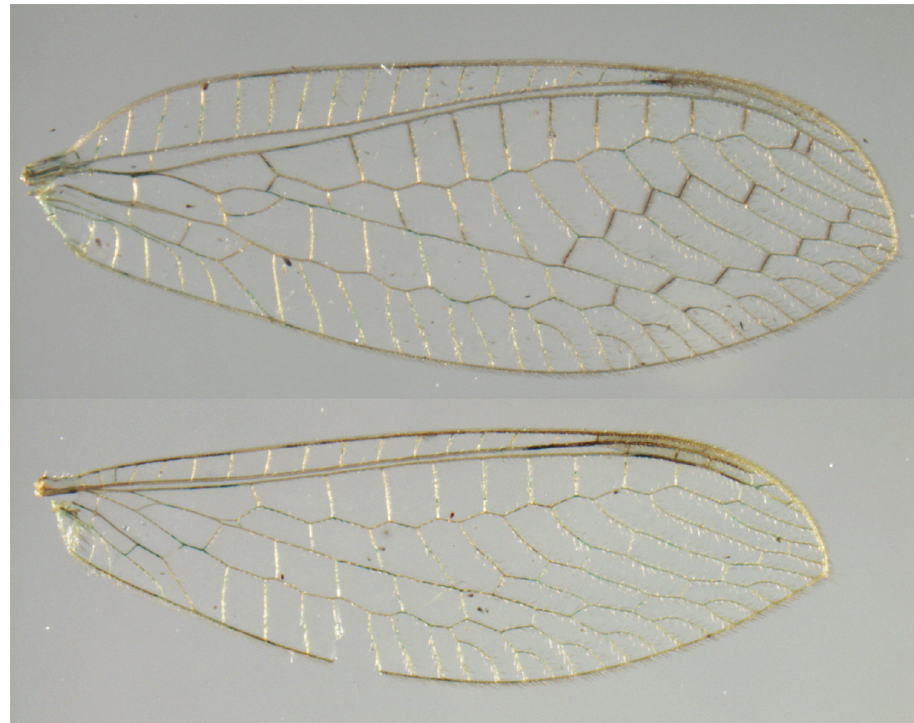
Figure 58. Ungla martinsi Sosa: Wings (Venezuela, Aragua, female, T9+ectoproct relatively long (~0.6× length of T7), with dorsal invagination deep (~0.5× dorsal length of T9+ect), margins of invagination almost straight, base rounded; dorsal margin of T9+ect sloped distally (above anus); posterior margin of ectoproct rounded throughout; ventral margin of T9+ect straight, with lightly sclerotized, straight apodeme, slightly below sclerotization around callus cerci, pos- terior corner of apodeme bent mesally in small, rounded knob; posteroventral cor- ner of T9+ect appearing angular (lateral view); callus cerci large, ovate, with entire margin lightly sclerotized. S8+9 fused, with line of fusion not readily perceptible; dorsal margin with apodeme extending along basal ~1/2 length of segment; segment extending further without apodeme, then gradually sloping ventrally to tip of seg- ment; terminus extending distally, well beyond tip of T9+ect, heavily sclerotized, upturned distally, concave in posterior view; terminal setae on posterodorsal margin of S8+9 enlarged, with small, flange-like protrusions basally. Gonarcus arcuate (dor- sal, ventral views), V-shaped (frontal, caudal views); bridge robust, moderately wide throughout; arms elongate, rounded distally, dorsal section with triangular process extending posteriorly toward gonosaccus; mediuncus with narrow base, paired in- ternal rods adjacent to each other for ~3/4 distance from base, fusing near terminus; dorsal surface of mediuncus fairly straight, with short, rounded (blunt) beak distally;